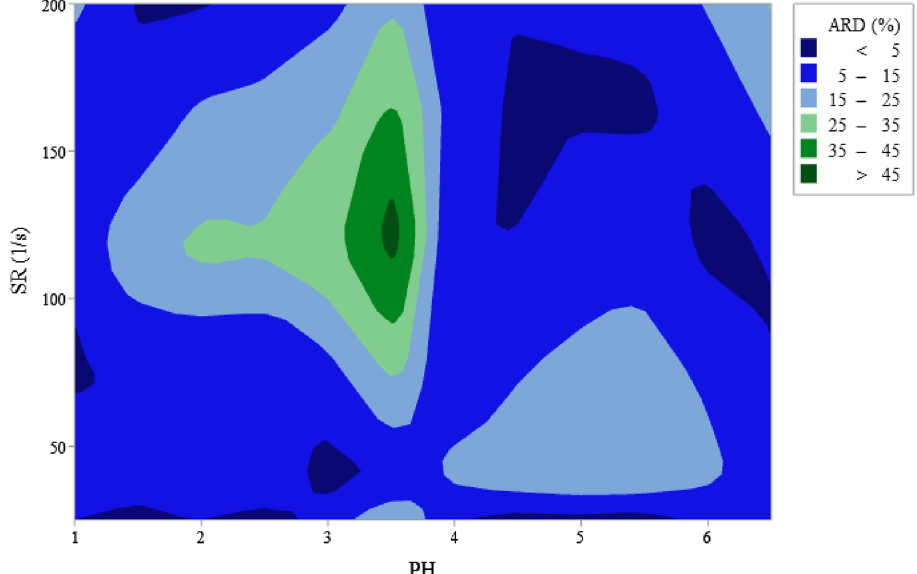
Fig. 6 The contour plot of the absolute relative deviation changes as a function of pH and shear